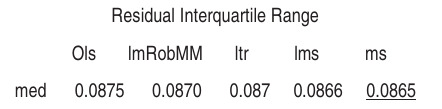
Table 4. Median Residual Inter-quartile Range by Regression Method for SP500